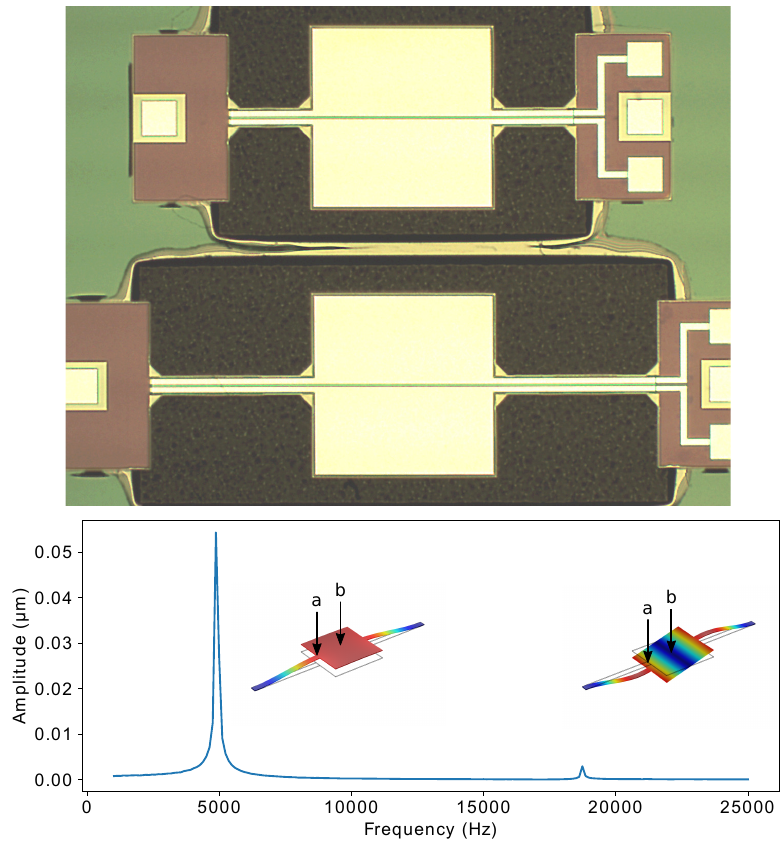
Figure 1. Top : Optical image of typical devices with different supporting beam lengths. The device used has 1050 µ m length beams supporting an 800 µ m square plate. Bottom : Coarse frequency sweep showing the two main modes. Displayed modeshapes were obtained from COMSOL simulations. Points “a” and “b” denote the location of the laser beam spot for the laser doppler vibrometer (LDV). The color code on the modeshapes indicates red for areas of maximum displacement and blue for no